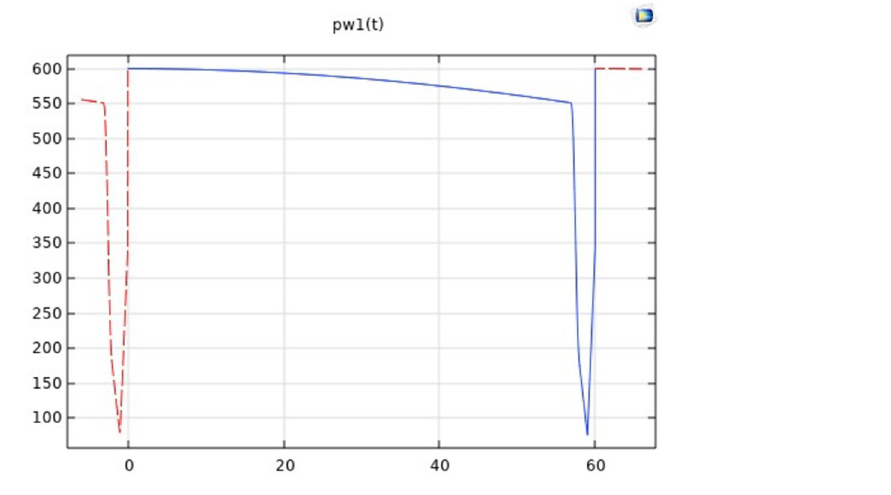
Fig 2. Temperature curve of